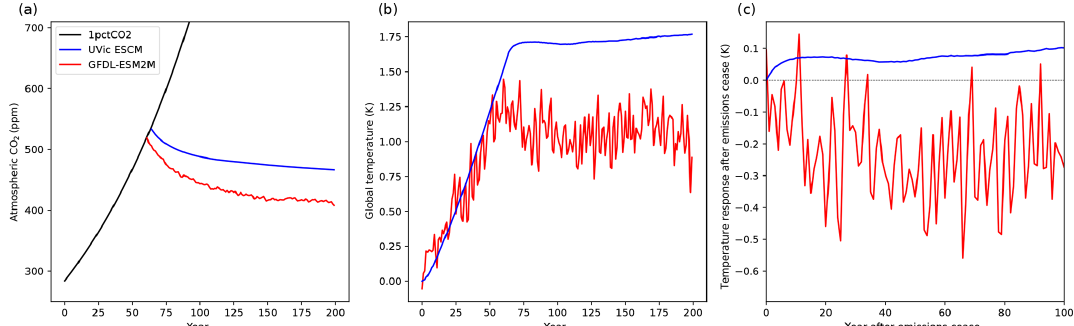
Figure 1. Example results from simulation A1 from the UVic ESCM (Weaver et al., 2001; MacDougall and Knutti, 2016; blue) and GFDL- ESM2M (Dunne et al., 2012, 2013; red) models. (a) CO 2 concentration prescribed (black line) in the 1pctCO2 simulation and simulated (red, blue lines) by the two models; (b) simulated global mean surface air temperature for the same period; (c) global mean temperature response from the branch point off the 1% simulation with zero subsequent emissions.